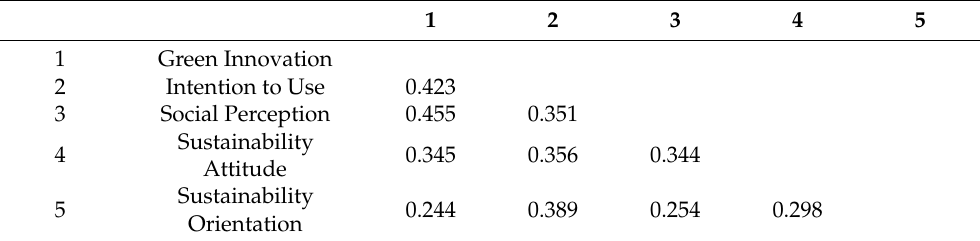
Table 5. The heterotrait-monotrait (HTMT) analysis for discriminant validity. 1